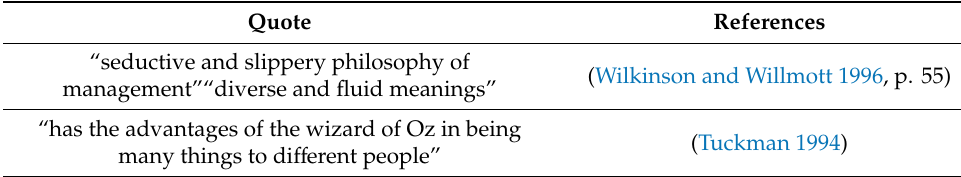
Table 1. Illustrative quotes about the interpretive space of Total Quality Management (TQM).